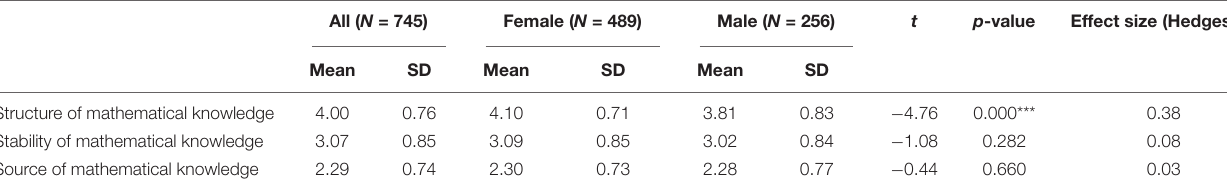
TABLE 2 | Results of the independent-samples t -test comparing female and male teachers on the three mathematical epistemic beliefs. All ( N = 745)